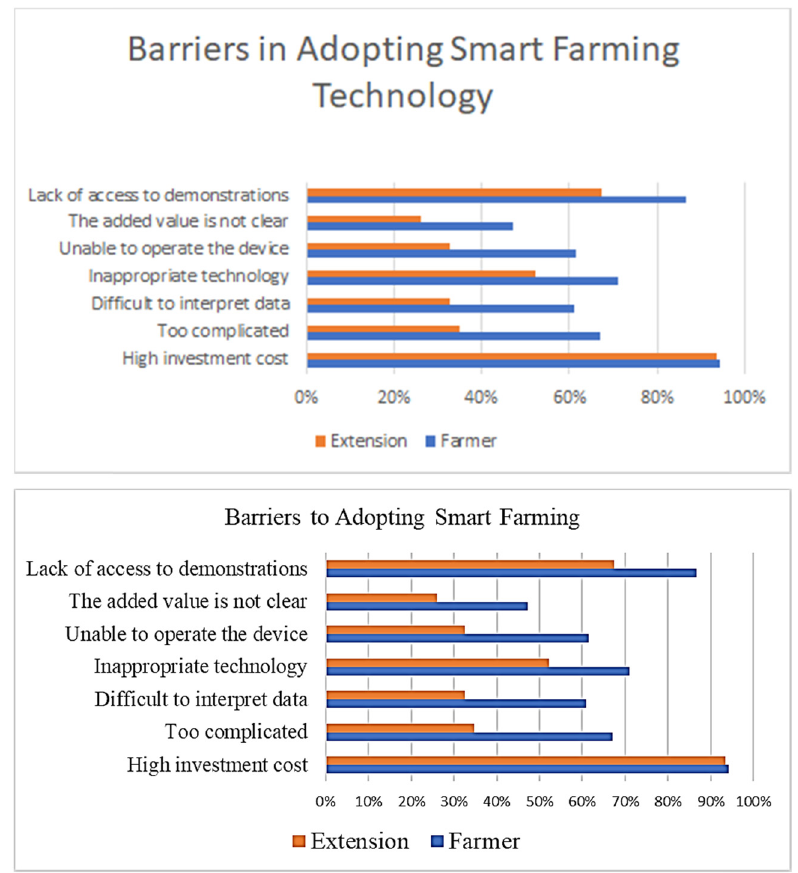
Figure 5: The inhibiting factors for food farmers in adopting SFT based on their perception of the